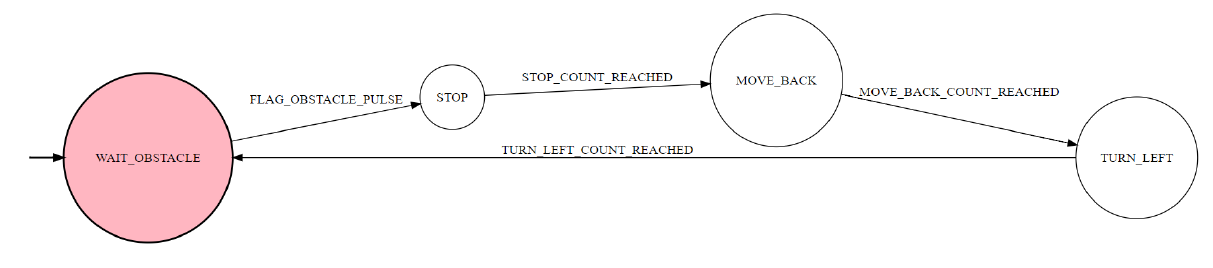
Figure 9. FSM block